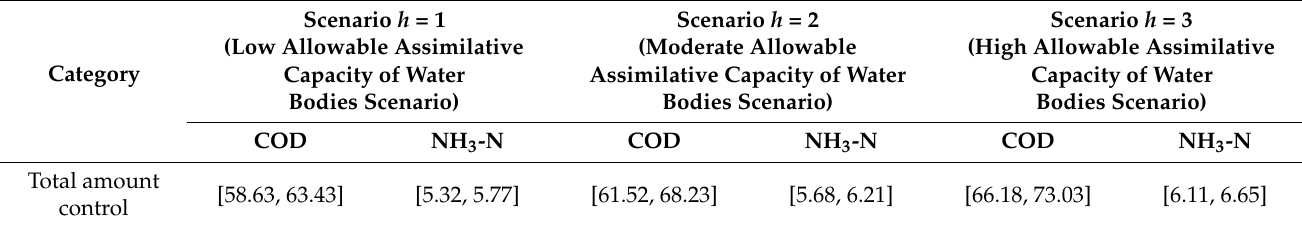
Table 1. Total amount control target of COD and NH 3 -N in the Yellow River Basin in 2030. (Unit: 10,000